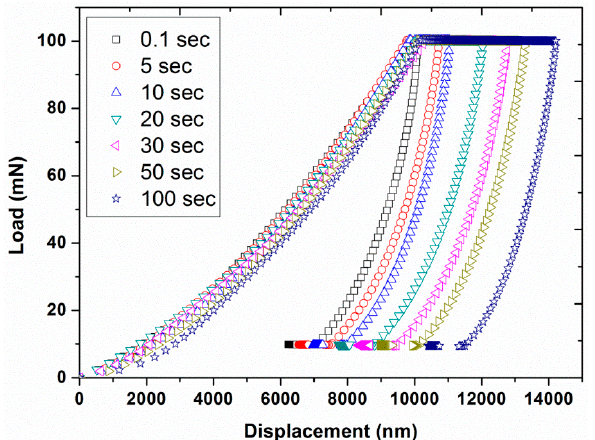
Figure 14. Indentation load as a function of displacement by having a peak load of 100 mN for various holding times (0.1, 5, 10, 20, 30, 50, and 100 s) with loading time of 10 s.